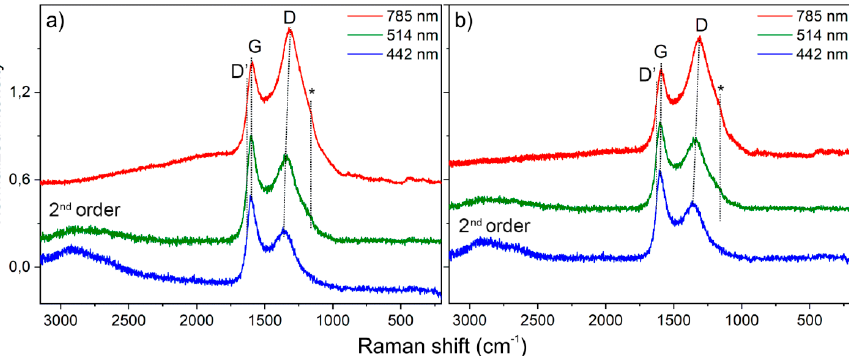
Figure 6. HRTEM images of ( a ) Char1.5 and ( b ) Char2.5. Raman spectra of Char1.5 and Char2.5, obtained employing three laser lines (785 nm, 514 nm, and 442 nm), are illustrated in Figure 7.